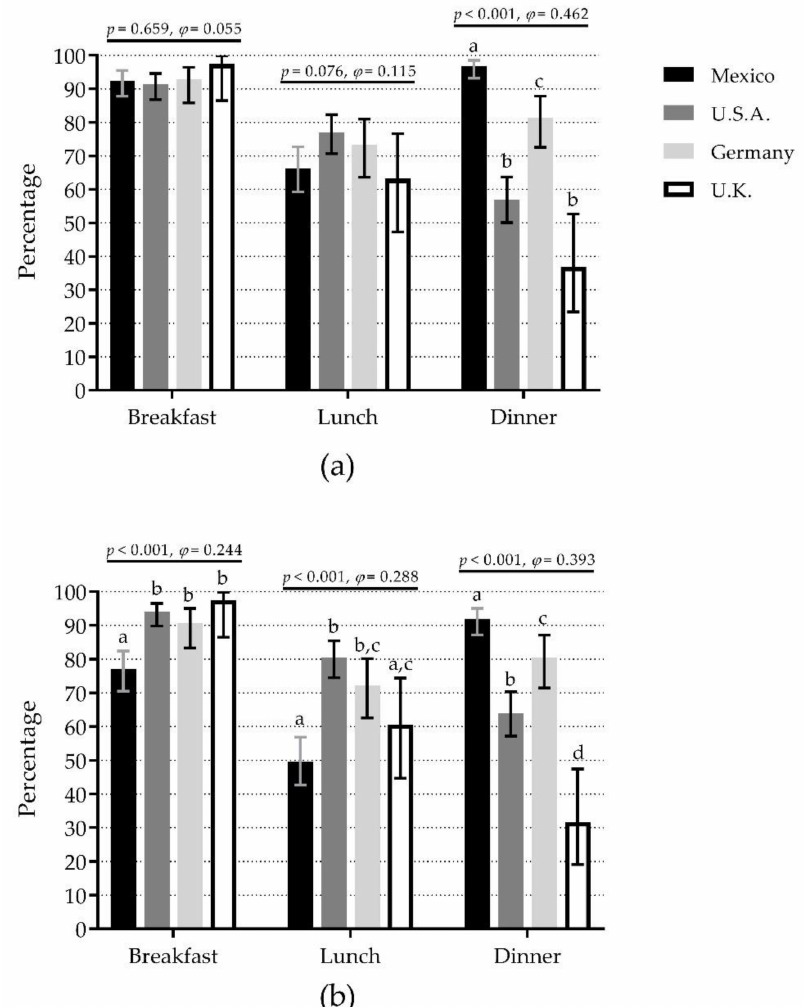
Figure 2. Comparison of inadequate protein intake per meal (breakfast, lunch, and dinner) among four countries depending on the protein content at each meal as < 30 g / meal ( a ) or < 0.4 g / kg body mass / meal ( b ). Bars represent the percentage of inadequate protein intake per meal; whiskers represent 95% confidence intervals. p -values and ϕ statistic are for comparisons among countries within meals ( χ 2 test of independence). Bars not sharing a similar letter (a, b, c, d) denote significant di ff erences ( p ≤ 0.05) among countries within meals ( t -test for proportions with Bonferroni correction). U.K.: United Kingdom; U.S.A.: United States of America. Detailed data can be found in Table